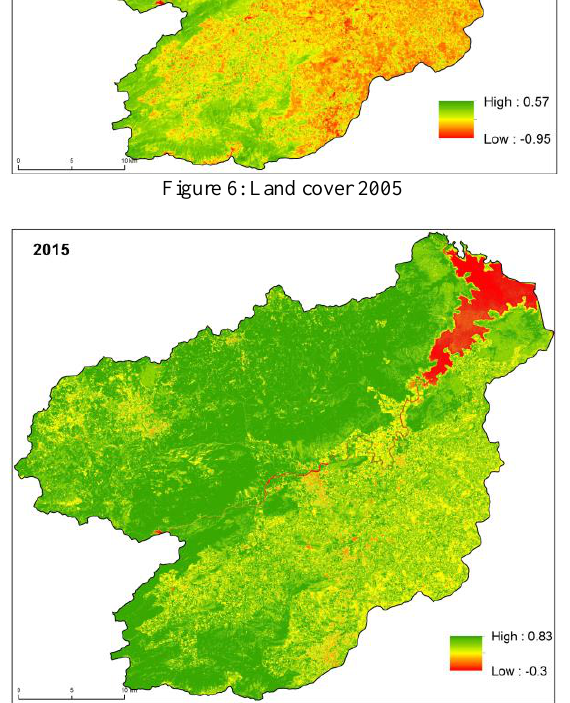
Figure 7: Land cover 2015